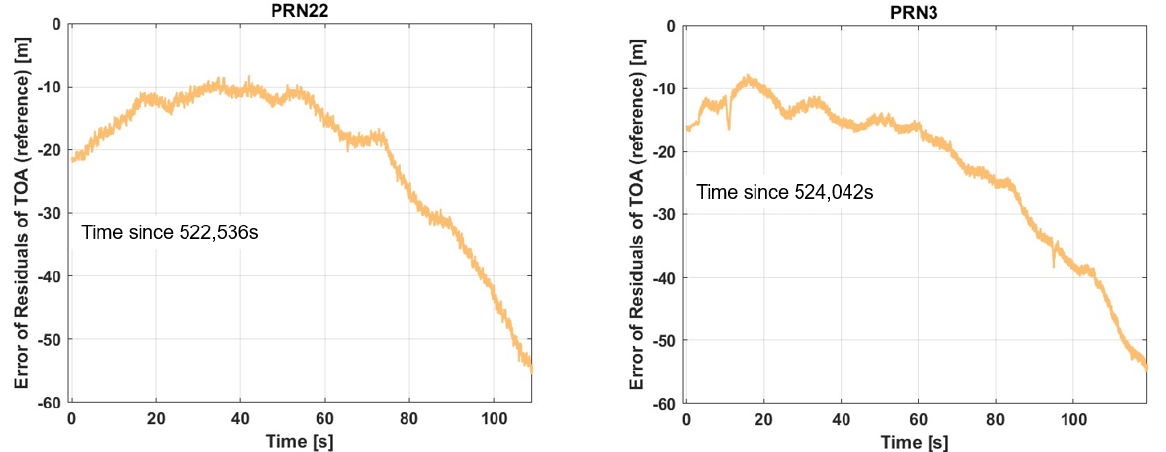
Figure 16. TOA curve references (regarding the error curves of the TOA residuals) derived from the ground-truth-based VDFPLL SDR. ( left ) TOA reference from PRN22 for the open-sky experiment ( right ) TOA reference from PRN3 for the semi-open-sky experiment.